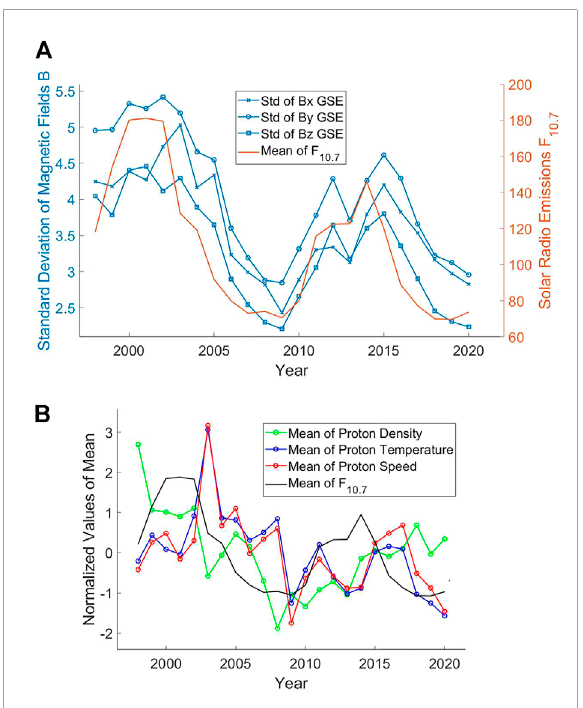
FIGURE 1 (A) Standard deviations per year of the three-components of the interplanetary magnetic field (Bx, By, Bz) in GSE coordinates compared to the mean per year of the solar radio flux at 10.7 cm from NASA’s OMNIWeb (omniweb.gsfc.nasa.gov/)—1998 to 2020. Values are not normalized here. (B) Mean of Proton Density, Temperature, Speed and Solar Radio Index F10.7 per year, from 1998 to 2020. All values are normalized (center 0 and standard deviation 1) to plot them on the same